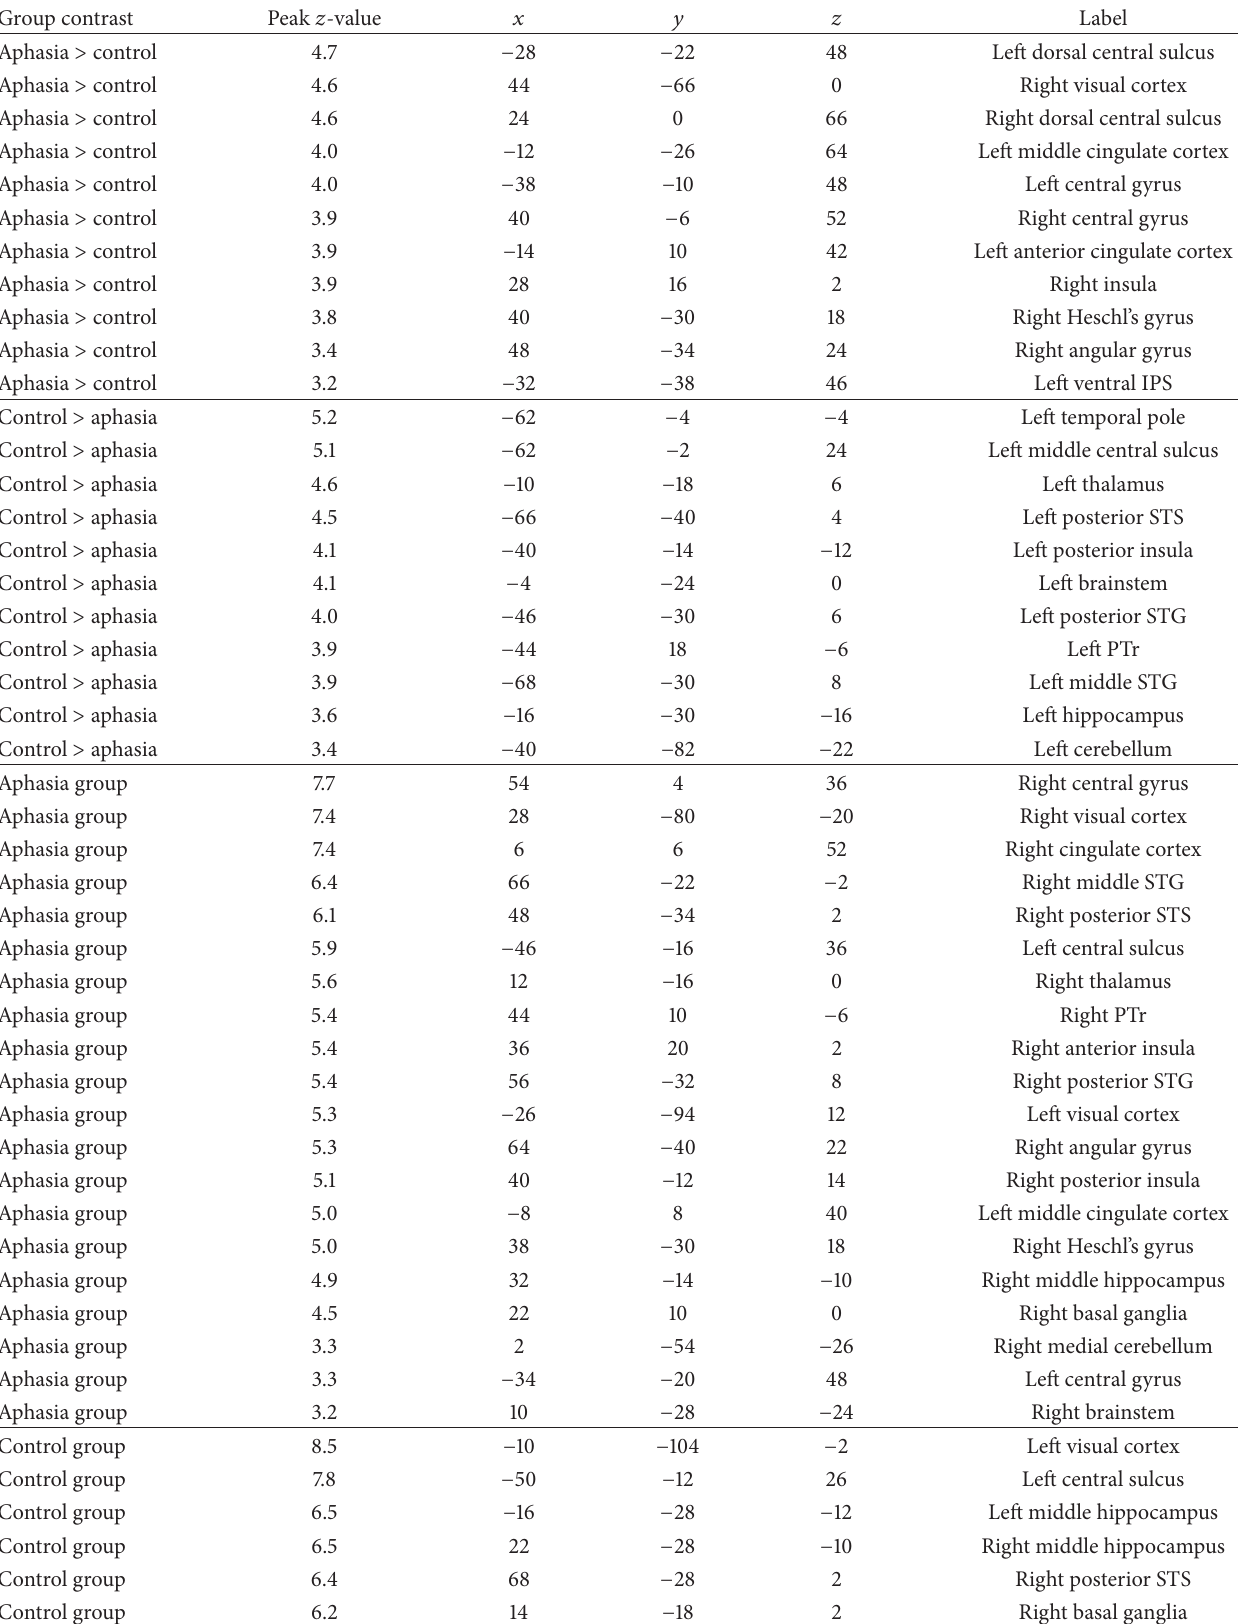
Table 3: MNI coordinates of activity in the overt naming > fixation